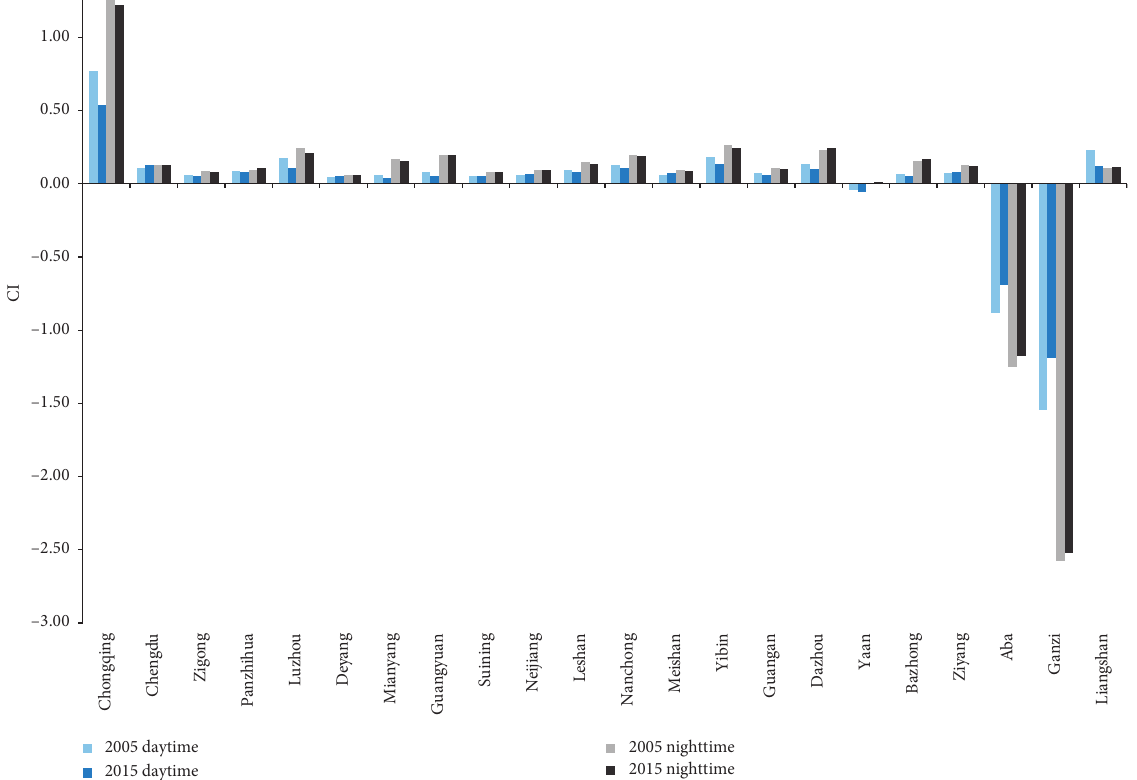
Figure 4: The thermal environment contribution indices of 22 cities for the Sichuan-Chongqing region between 2005 and